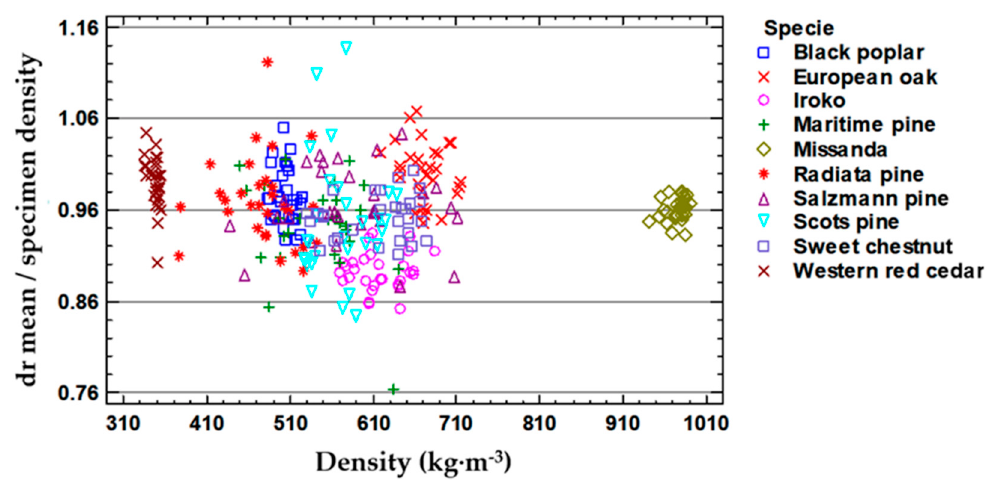
Figure 5. Distribution plot of the ratio of dr density/specimen density depending on the specimen’s density.